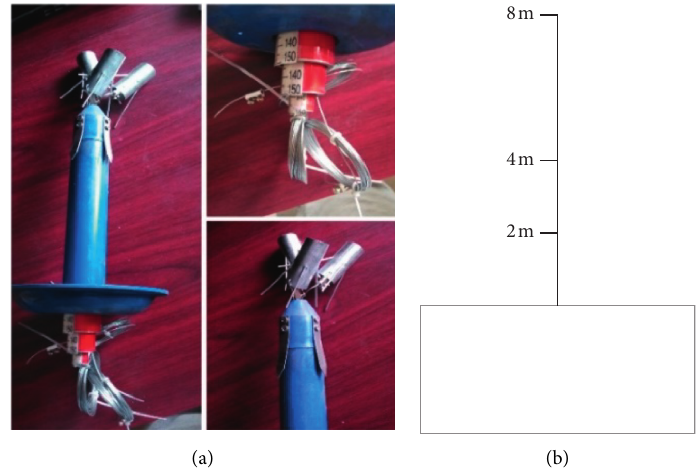
Figure 5: Separation monitor and its arrangement. (a) 3-basis points separation monitor. (b) Basic point arrangement of separation monitor.